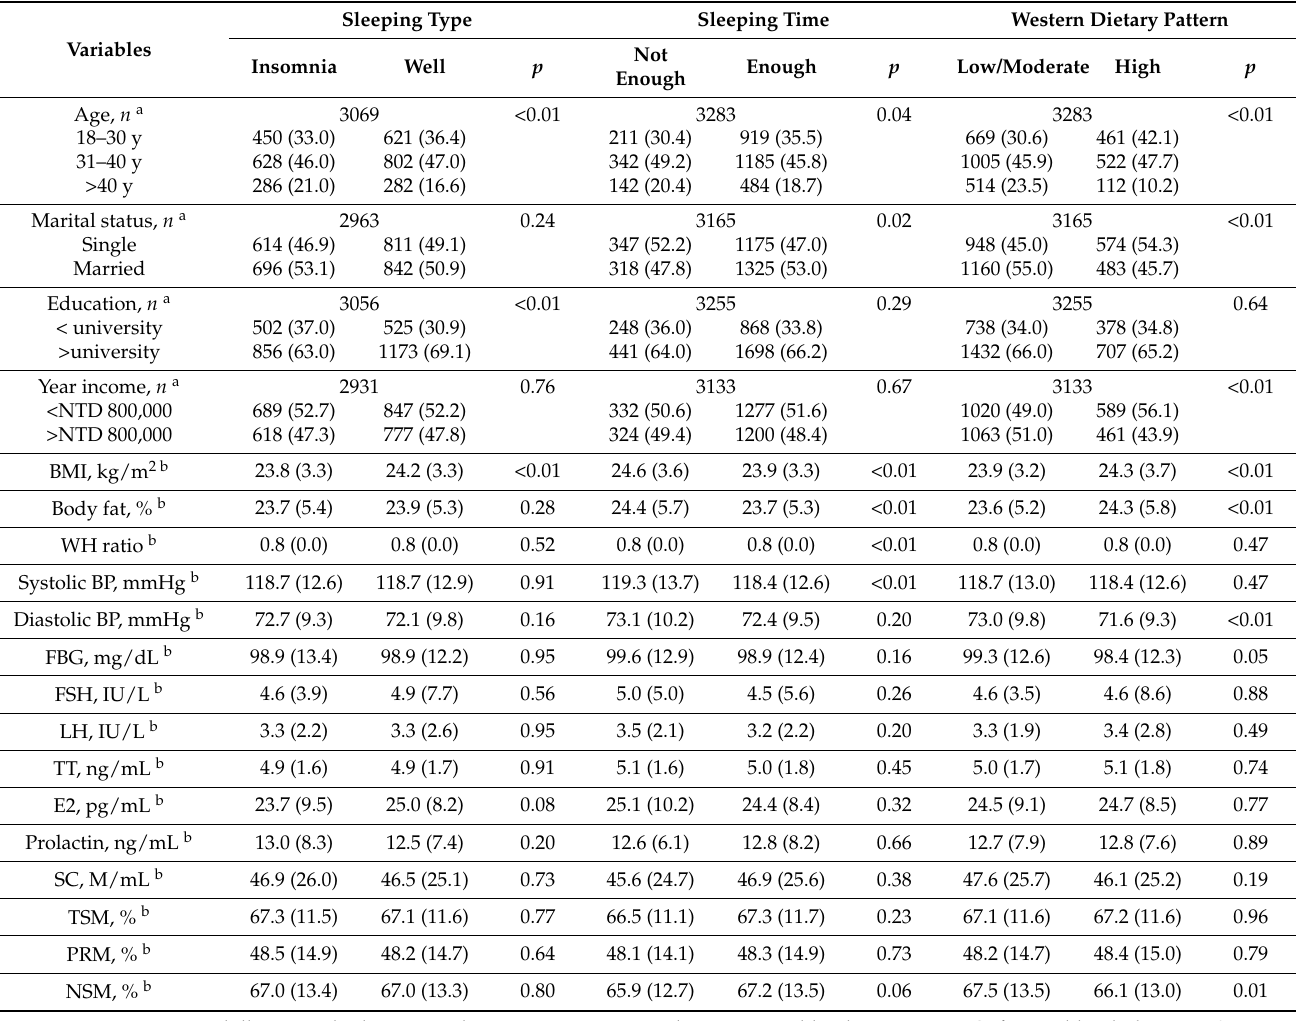
Table 2. Characteristics of men according to sleeping status and Western dietary